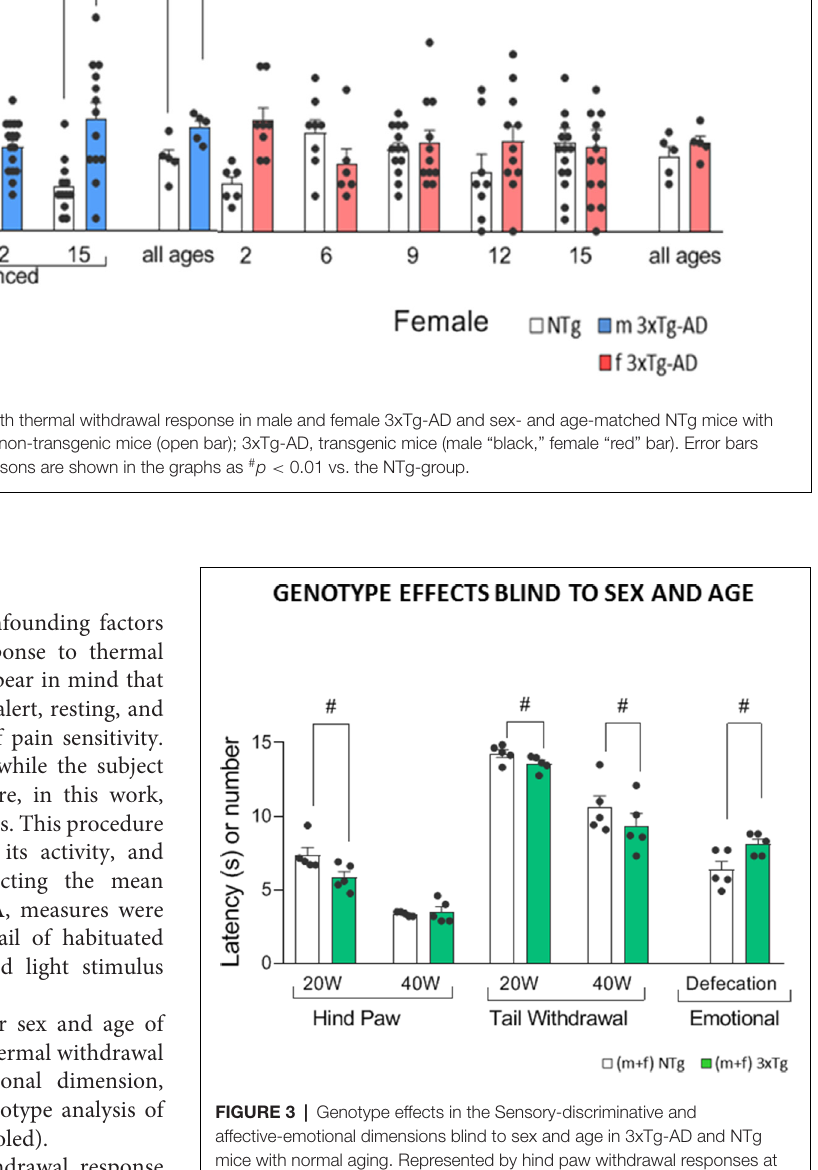
all ages, Paw-20W; #G (genotype effect), t (107) = 4.30, p < 0.001. Paw-40W; #G, t (107) = 2.42, p = 0.0017. Tail- 20W; G, t (107) = 3.39, p = 0.001. Tail-40W; G, t (107) = 3.43, p = 0.001), indicating increased sensory-discriminative pain